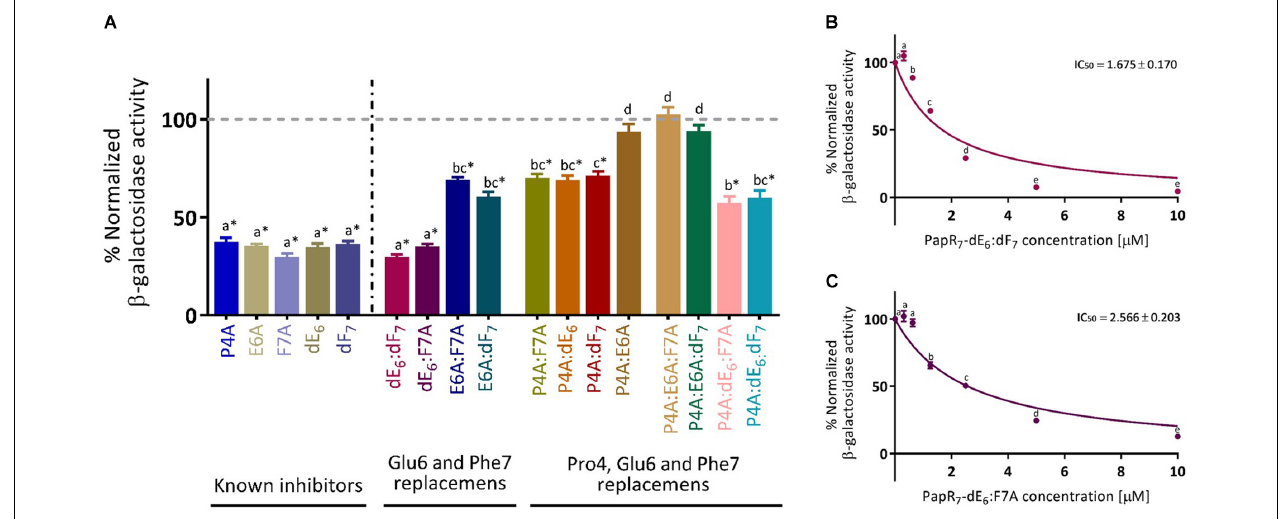
FIGURE 3 | Competition studies with new PapR 7 -derived peptide combinations. (A) β -galactosidase activity of Bt A’Z induced by the addition of 2.5 µ M PapR 7 -derived peptides, (B) PapR 7 - dE 6 :dF 7 , and (C) PapR 7 -dE 6 :F7A derivatives in several concentrations normalized to untreated bacterial cells at late-exponential of bacterial growth (OD 600 of 1.8 ± 0.1, mean ± SEM, n = 9). ∗ p < 0.01 indicates a statistically significant difference between untreated Bt A’Z and addition of PapR 7 -derived peptides. Different letters indicate statistically significant differences between PapR 7 -derived peptide treatments ( p < 0.01).